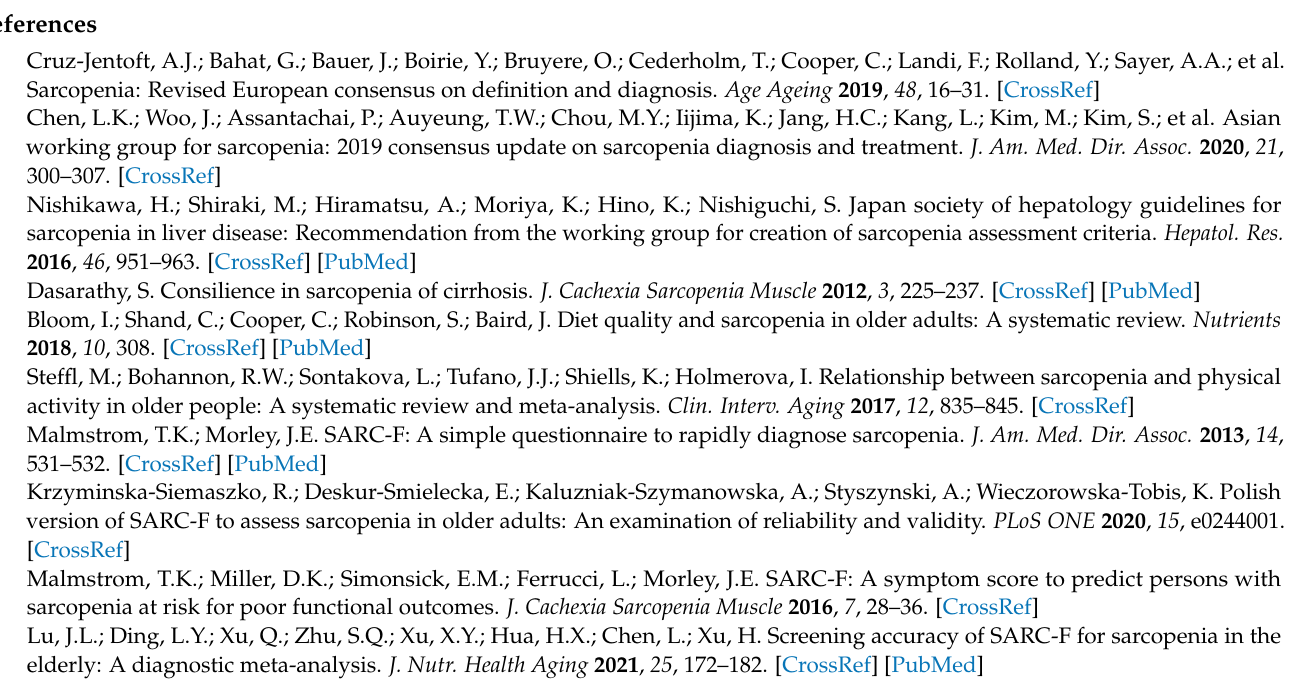
sarcopenia, Table S2: Comparison of body compositions of patients with a SARC-F < 4 and those with ≥ 4, Table S3: Baseline characteristics of patients with and without sarcopenia according to sex, Table S4: Sensitivity, specificity, and positive and negative predictive values for sarcopenia according to sex, Table S5: Baseline characteristics of patients with and without sarcopenia according to age, Table S6: Sensitivity, specificity, and positive and negative predictive values for sarcopenia according to age, Table S7: Baseline characteristics of patients with and without sarcopenia according to sarcopenia diagnostic methods, Table S8: Sensitivity, specificity, and positive and negative predictive values for sarcopenia according to sarcopenia diagnostic